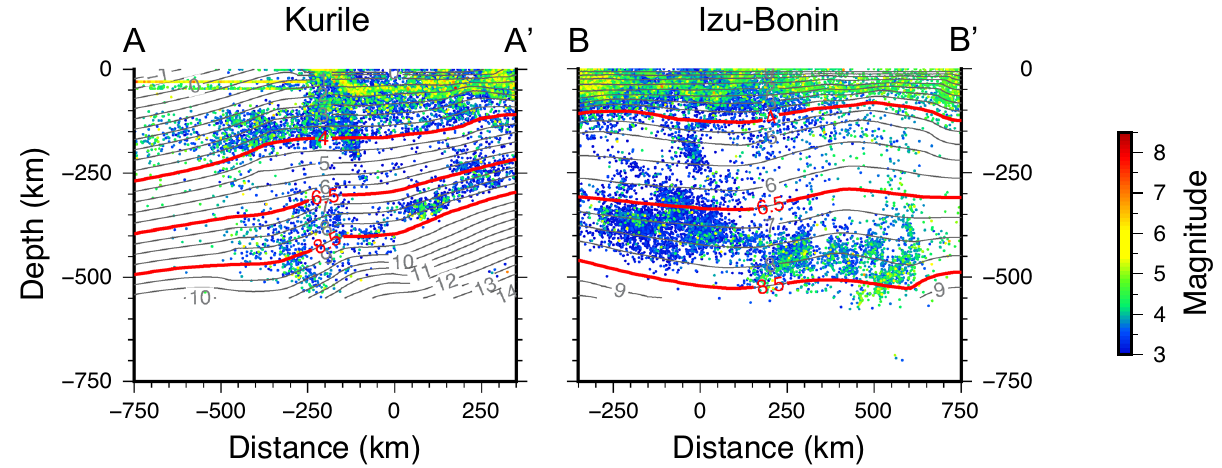
Figure 2. Vertical sections of the seismicity, along the profiles reported in Fig. 1. The profiles are parallel to the trench of the Kurile and Izu–Bonin subduction zones. The lines of equal age from the start of subduction at the trench are also displayed 52 . Apparently, in Izu–Bonin the slab reaches significantly larger depths in the same time span (e.g., 8.5 Ma), implying larger average sink velocity. The intermediate earthquakes are mainly localized at depths characterized by slab age younger than 4 Ma, while the deep events are prevalently enclosed